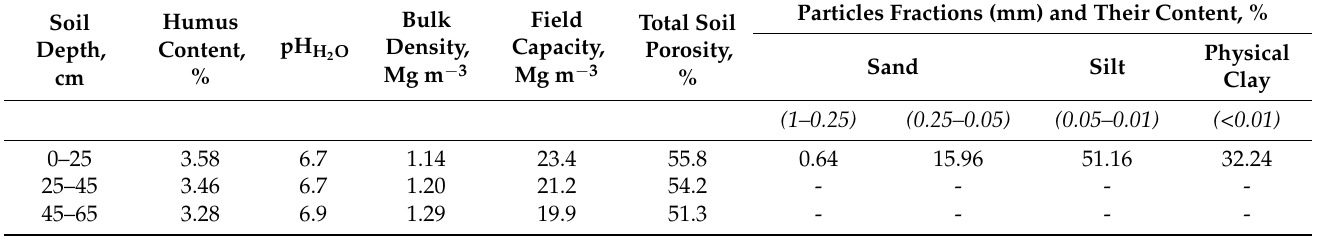
Table 1. Major properties of Typical Mollisol.